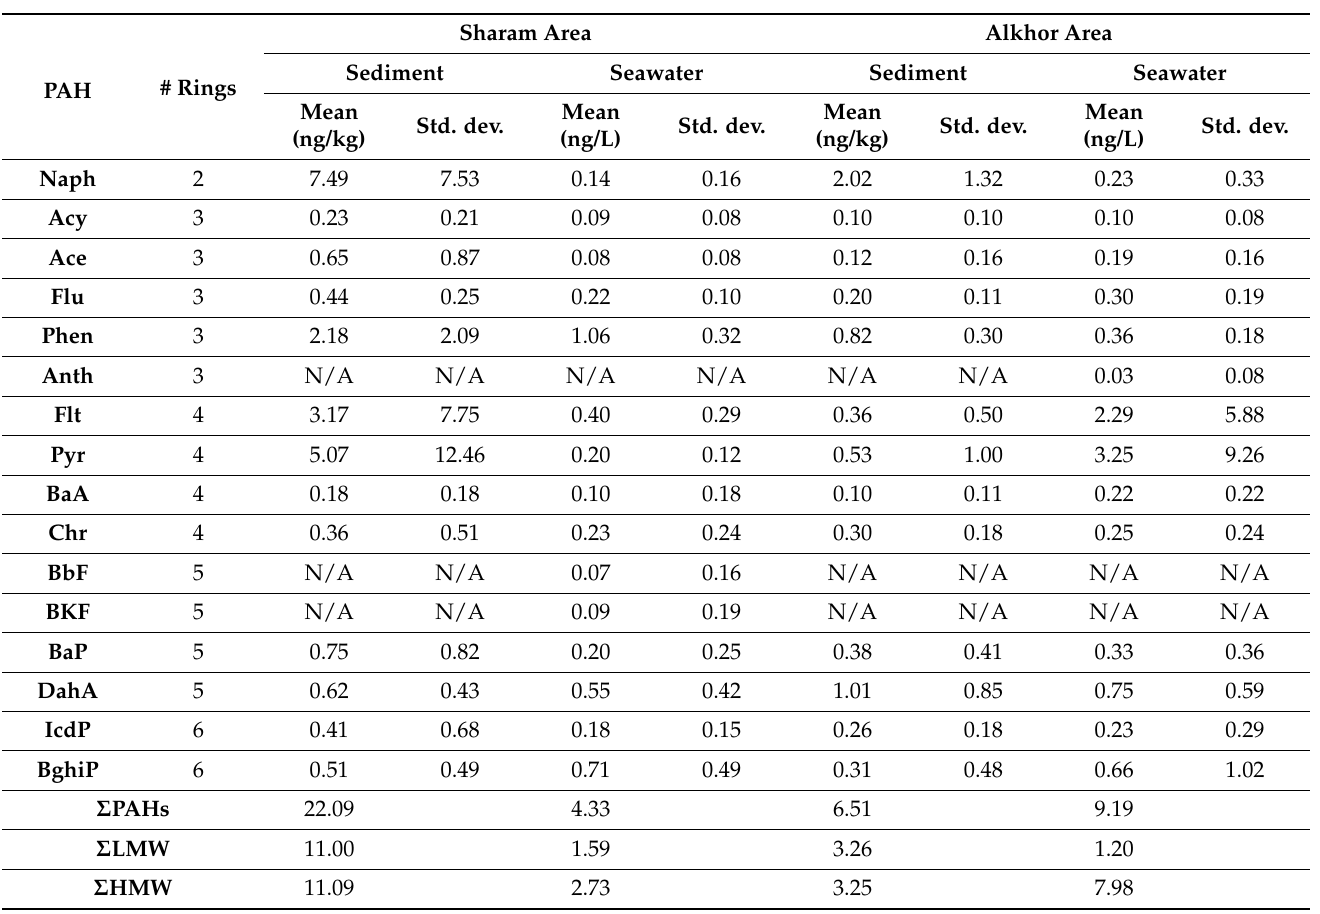
Table 2. Concentrations of PAHs in the water and sediment samples from the Sharam area and Alkhor